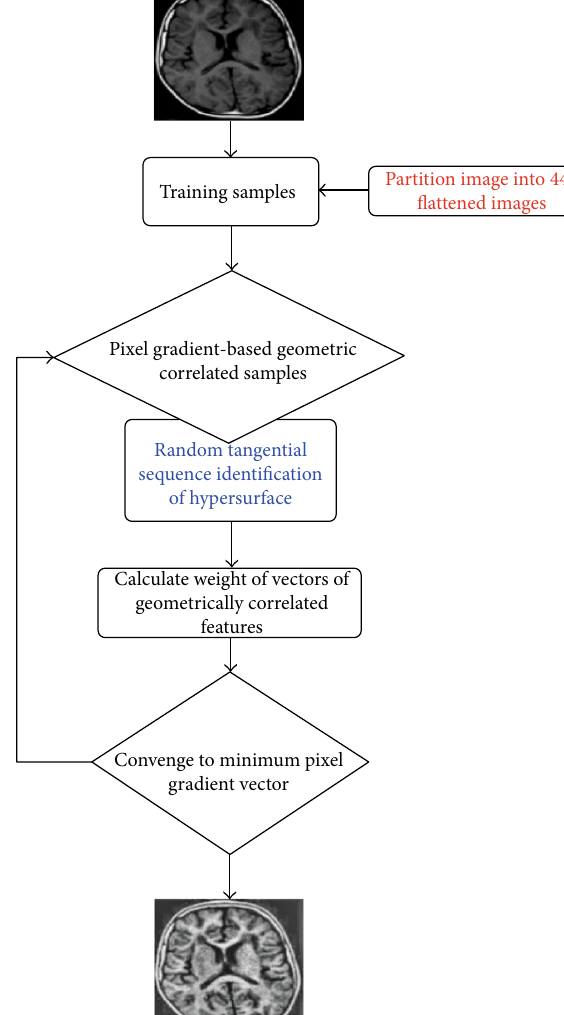
Figure 1: Schematic diagram indicating key steps of the proposed algorithm for the results presented in Figures 3 and 4. The MHNN proposed is composed of 4 layers: one input layer, two hidden layers, and one output